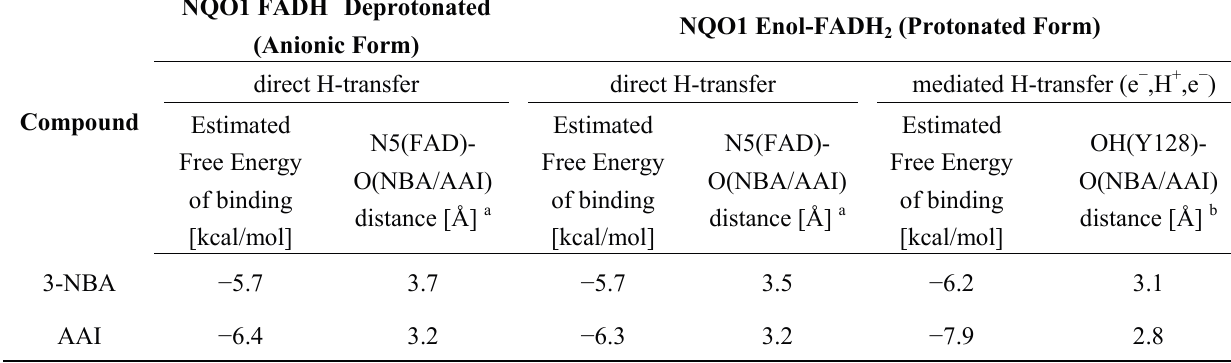
Table 4. The predicted binding free energies and distances facilitating the H-transfer for AAI, 3-NBA and their reduced metabolites to human NQO1. The data is taken from previous studies